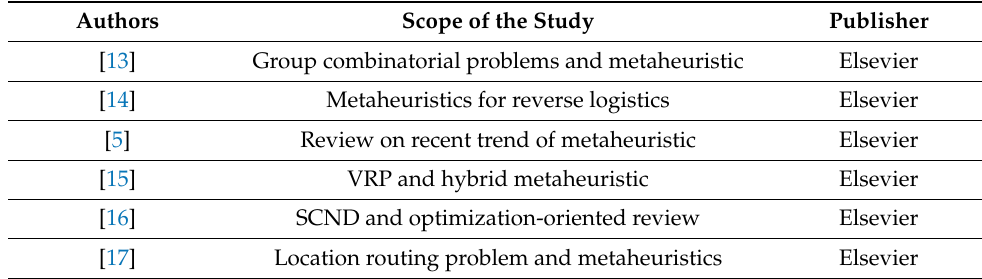
Table 1. Recent literature on combinatorial optimization